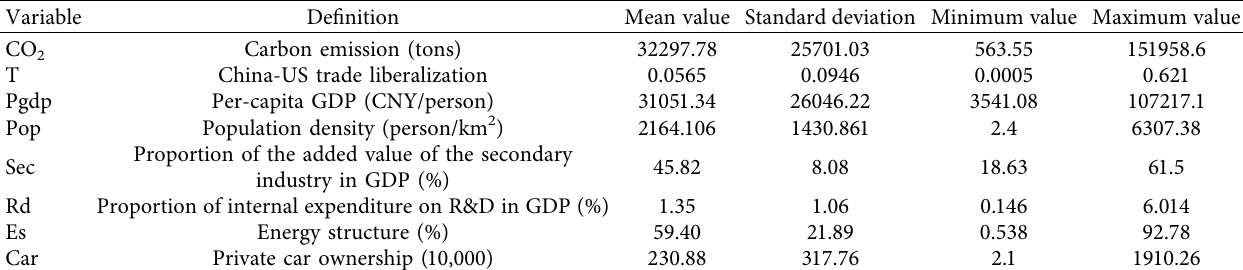
Table 1: Variable statistical